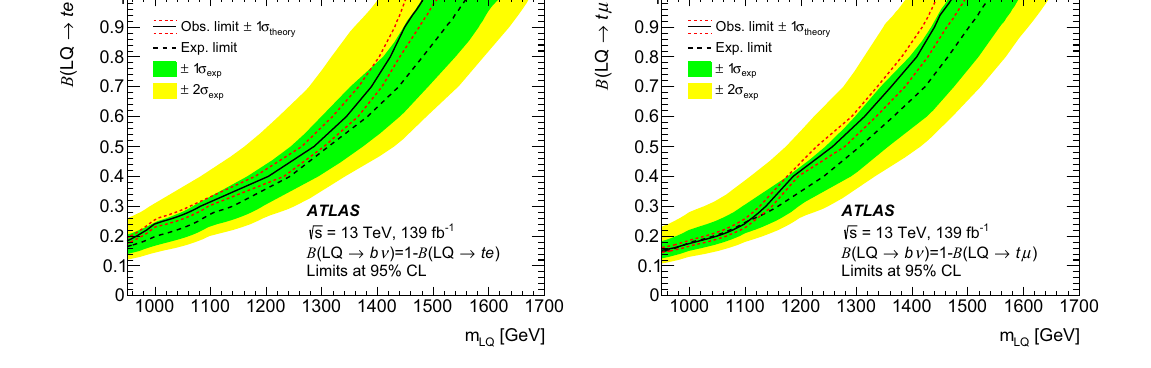
Fig. 6 Lower exclusion limits on the leptoquark mass for scalar lep- toquark pair production as a function of the branching ratio into a top quark and an electron (left) or a muon (right) at 95% CL. The observed nominal limits are indicated by a black solid curve, with the surround- ing red dotted lines obtained by varying the signal cross section by